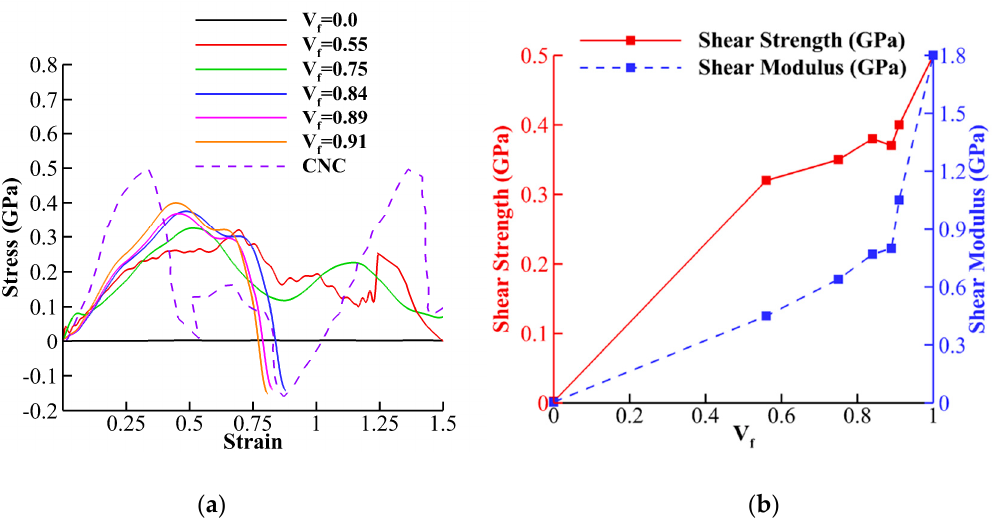
Figure 10. ( a ) Shear stress-strain curves for stress transfer between CNT-wrapped cellulose and ( b ) extracted strength and shear modulus from stress-strain curves are shown.